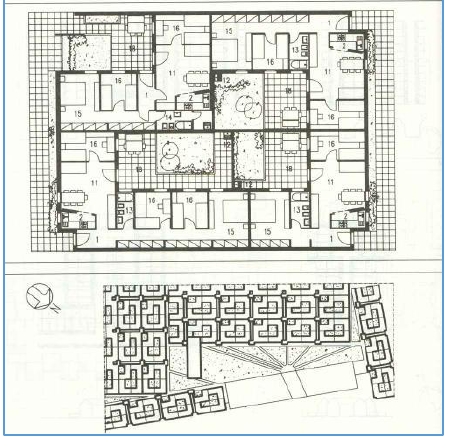
Figure 8. L- Shape patio ‘Courtyard’ Sources: Fabrizi, M. (2014)